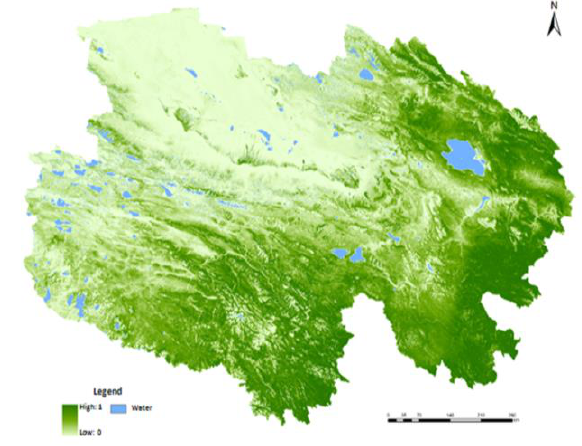
Figure 2. The FVC map of QingHai Province in 2013 August